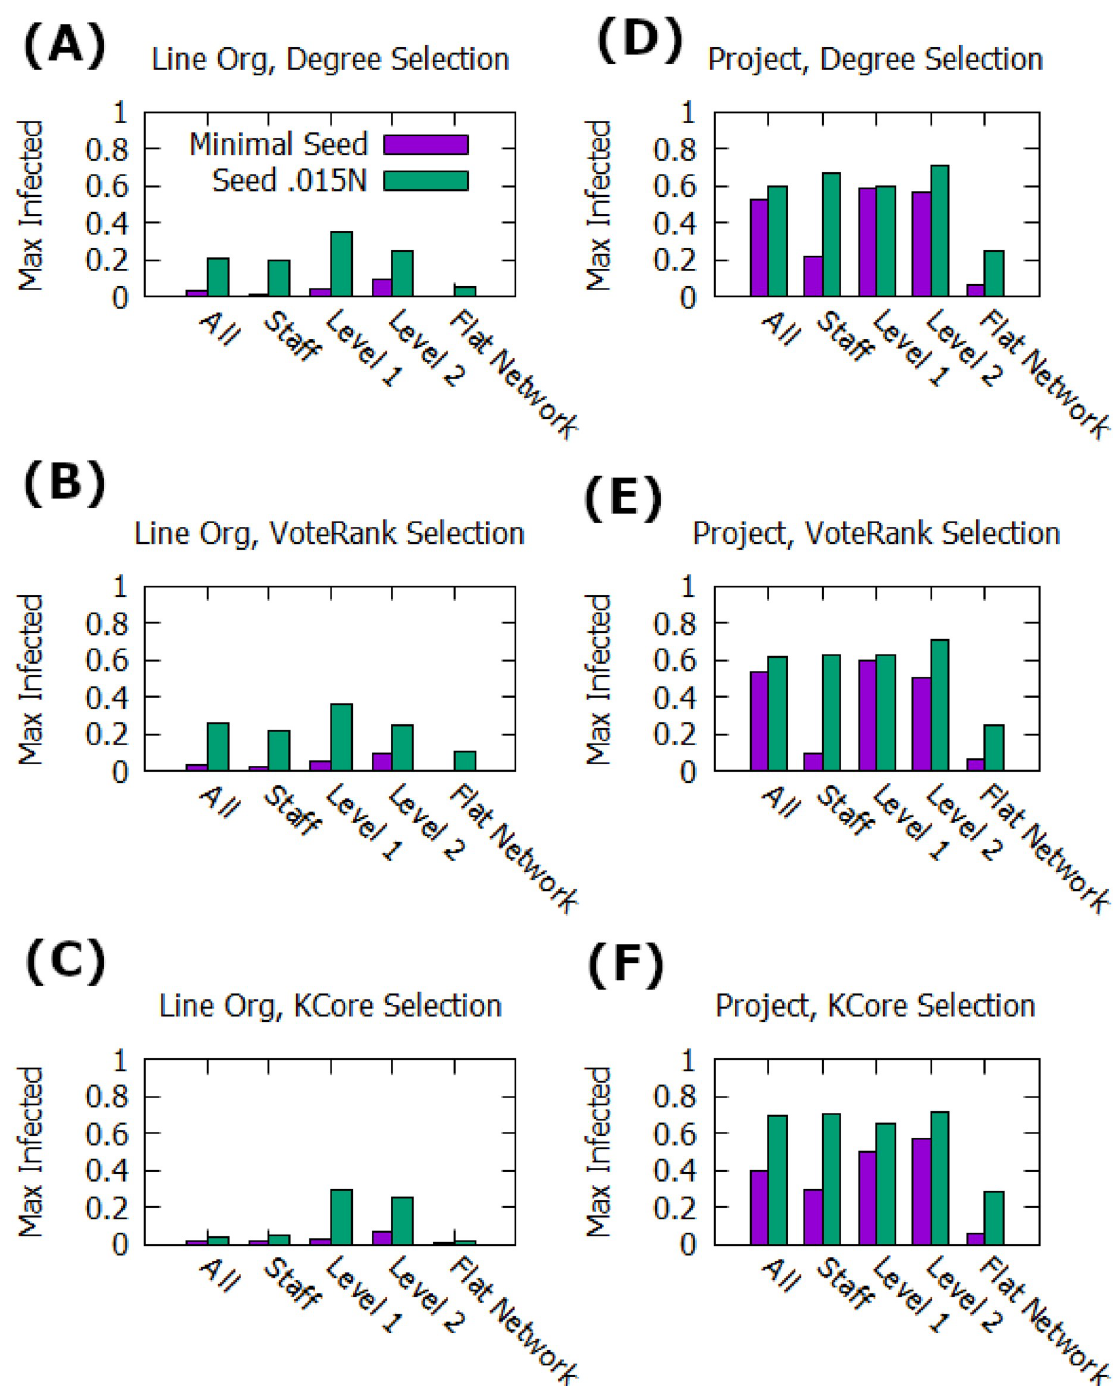
Fig 7. Max adoption with SIR dynamics. Shows the average maximum population of nodes in state I for each combination of network, seed size, and seed level, and selection algorithm averaged over 1000 runs. Includes a ‘flat network’ consideration, where management advantages are removed and an ‘all’ seed level where seeding is done by highest connected node regardless of level. A-C: Average max reach in the Line Org network structure for different seed selection strategies. D-F: Average max reach in the Project network structure for different seed selection